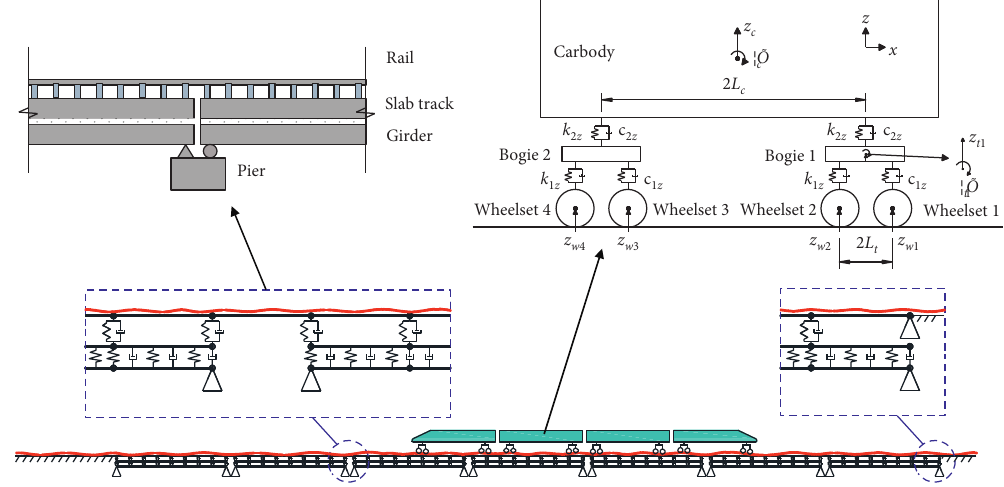
Figure 1: Train-track-bridge